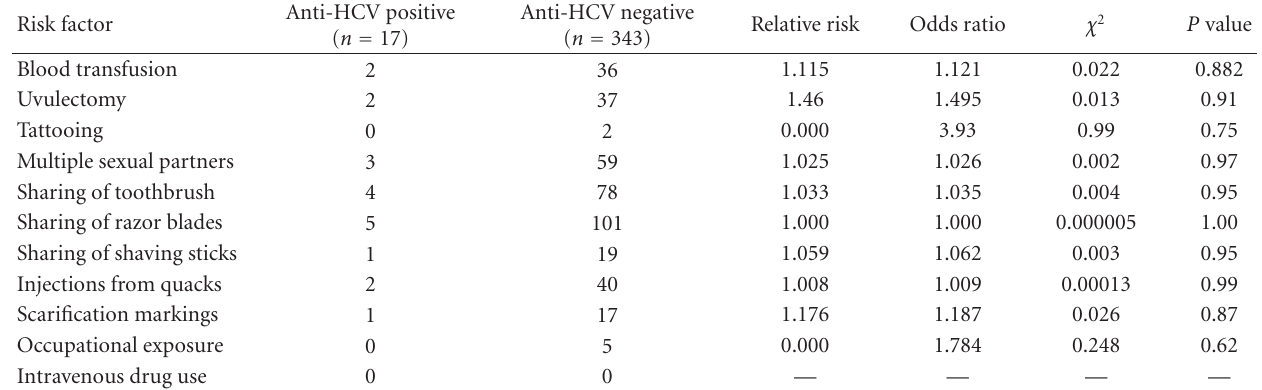
Table 2: Risk factors for HCV